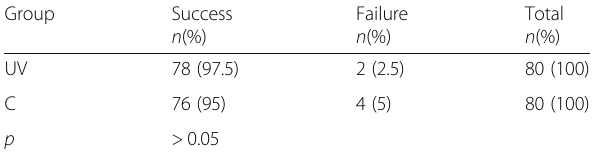
Table 3 Clinical performance (success and failure) in clinical bonding for UV group and control group: n and frequency (%) of occurrence, chi-squared test ( p )